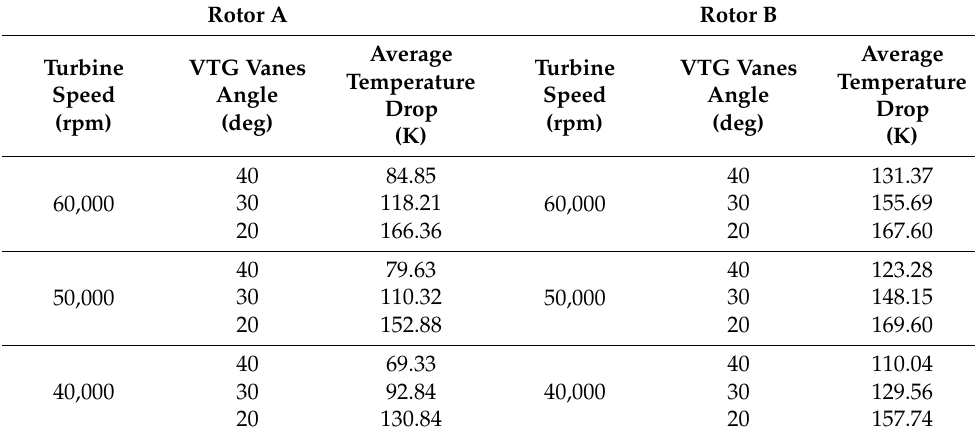
Table 11. The average values of the outlet temperature from the second-stage rotor for two different rotor